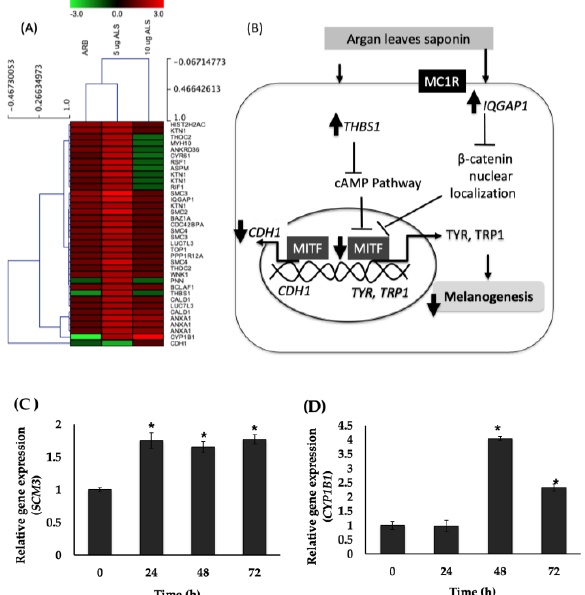
Figure 5. Global gene expression analysis of the effect of saponins-rich fraction of argan leaf (ALS) on human epidermal melanocytes (HEMs). ( A ) Heat map and hierarchical clustering of ALS-modulated genes in HEM. Clustering was calculated using Euclidian distance in TIGR’s MultiExperiment Viewer v4.9.0 software. Rows represent genes, whereas columns show experimental samples. Gene expression ratios are presented in the heat map using green (downregulated) and red (upregulated) color codes. ( B ) Signaling pathways through which ALS inhibit melanogenesis. ( C , D ) Gene expression of SCM3 and CYP1B1 genes upregulated by ALS as determined by TaqMan real-time PCR[29 – 31]. Based on the heat map, arbutin and 5 µg/mL ALS modulated the same set of genes except for PNN and THBS1 , which were decreased in the expression in arbutin and 10 µg/mL ALS. For the sample cluster, 5 µg/mL ALS was clustered with arbutin (50% similarity). Validation by real-time PCR of the genes that were highly upregulated, based on DNA microarray results (Table 1), shows that SCM3 and CYP1B1 genes’ expression s were indeed increased by ALS (Figure 5C,D).